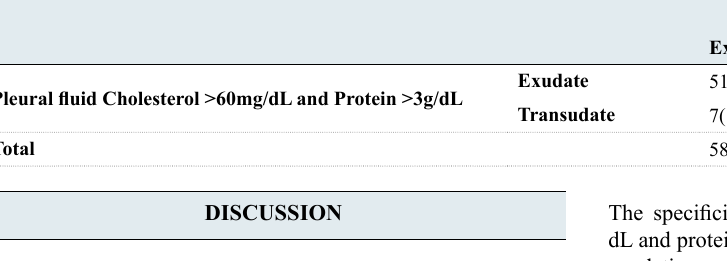
Diagnosis at discharge Total Exudate Transudate